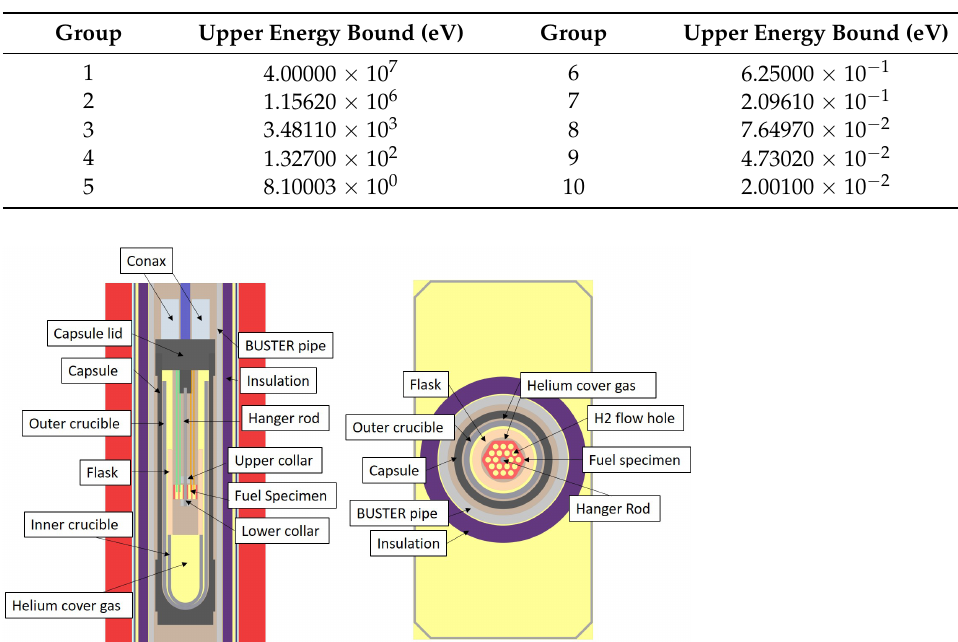
Table 1. Ten-group structure used for Griffin calculations.